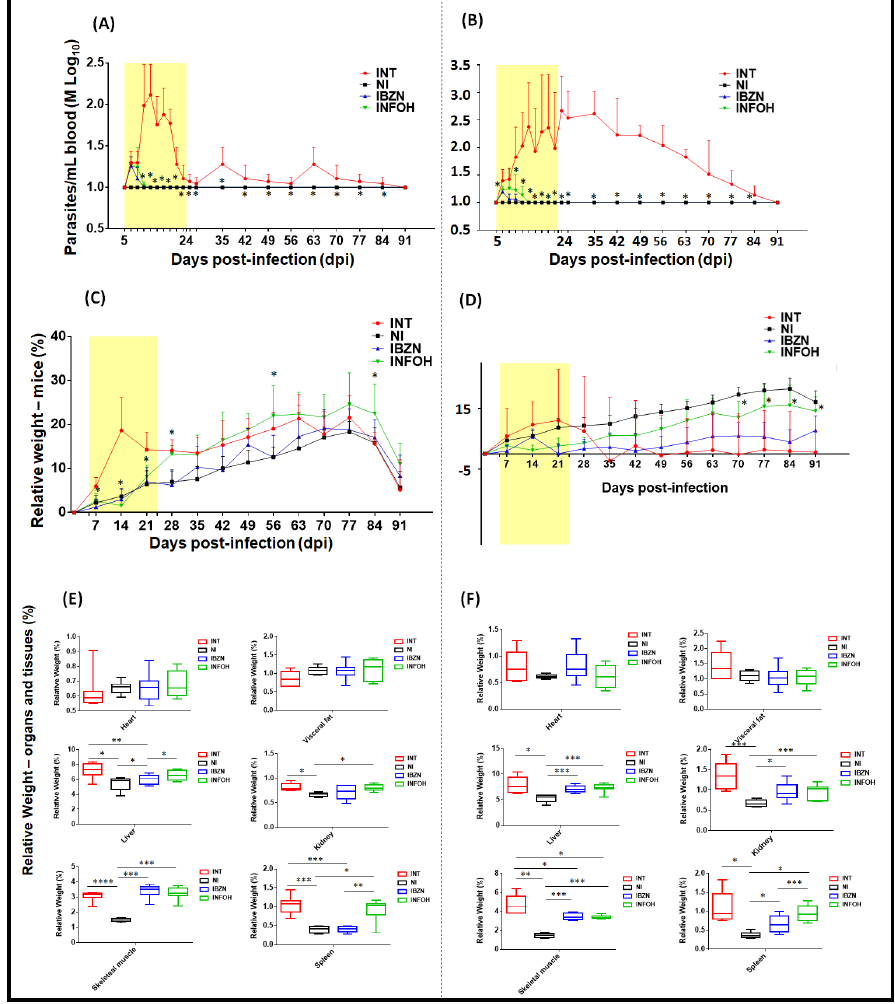
FIGURE 1 - Parasitaemia and relative weight monitoring in two different murine models (Swiss and C57Bl/6). ( A, B ) T. cruzi TcI (Bolivia strain) parasitaemia curves from infected mice (INT, IBZN, and INFOH) are expressed as logarithmic means (M log ). The treatment period is highlighted in yellow (20 days: BZN 100mg/kg and NFOH 150 mg/kg). The data are expressed 10 as averages of ± SD. *Statistically significant difference ( p ≤ 0.05 ). ( C, D ) Relative weight during protocol. ( E, F ) Relative weight of the organs (heart, visceral fat, liver, kidney, skeletal muscle, and spleen). INT: infected non-treated group, only vehicle; NI: non-infected group, only vehicle; IBZN: infected and treated with benznidazole; INFOH: infected and treated with hydroxymethylnitrofurazone. The data are expressed as averages of ± SD. Analysis of variance by Student’s t-test or one- way ANOVA, with Tukey’s post-hoc correction in GraphPad Prism v.7. Differences of p < 0.05 were considered significant. *Statistically significant difference ( p ≤ 0.05 ); **Statistically significant difference ( p ≤ 0.005 ); ***Statistically significant ( p ≤ 0.0005 ); The data are expressed as averages of ±